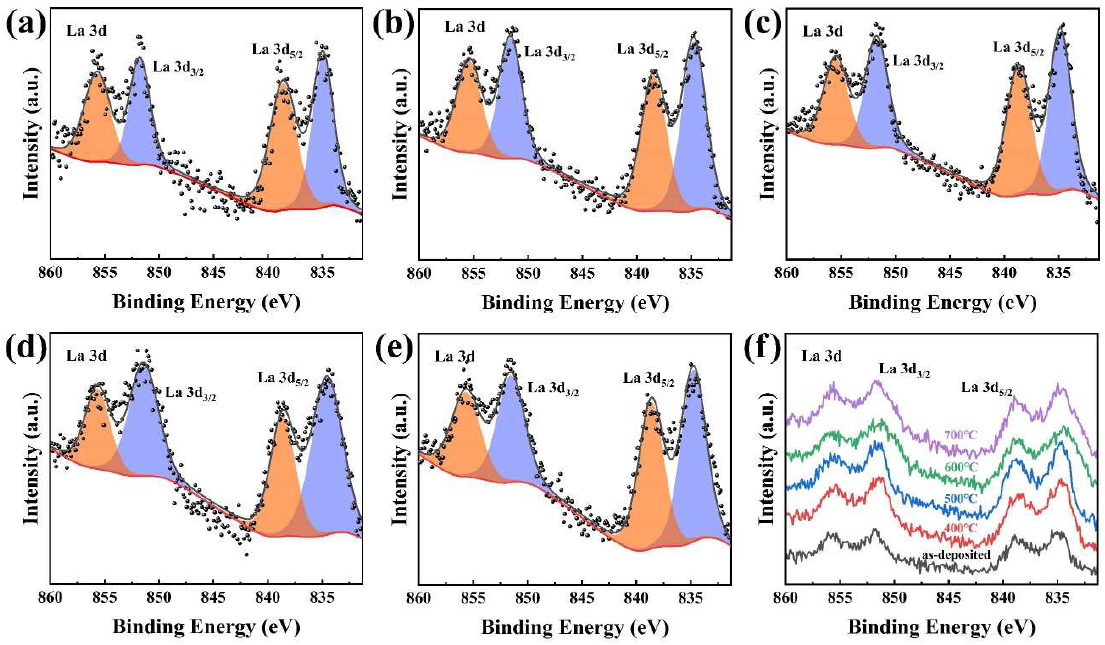
Figure 8. ( a – e ) La 3d XPS spectra of lanthanum-doped HfO 2 films at different temperatures. ( f ) La 3d XPS spectral stacking diagram.